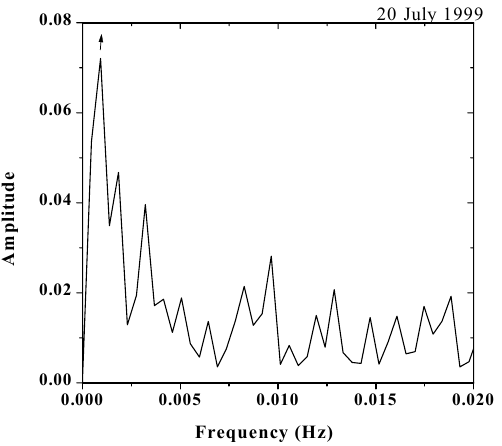
Fig. 1. A typical plot showing the identification of the Brunt- V¨ais¨al¨a frequency from the radar vertical velocities using the Fast Fourier Transform analysis technique from the spectra of vertical velocities at a 10.2km height taken on 20 July 1999. The arrow in the figure shows the Brunt-V¨ais¨al¨a frequency at that height.